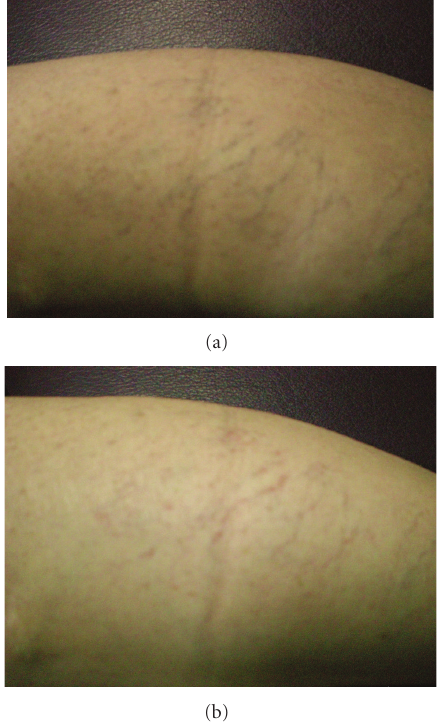
Figure 3: (a) Facial telangiectasia of a patient before treatment, (b) facial telangiectasia in the patient after third session of the treatment, Category-II (marked improvement).